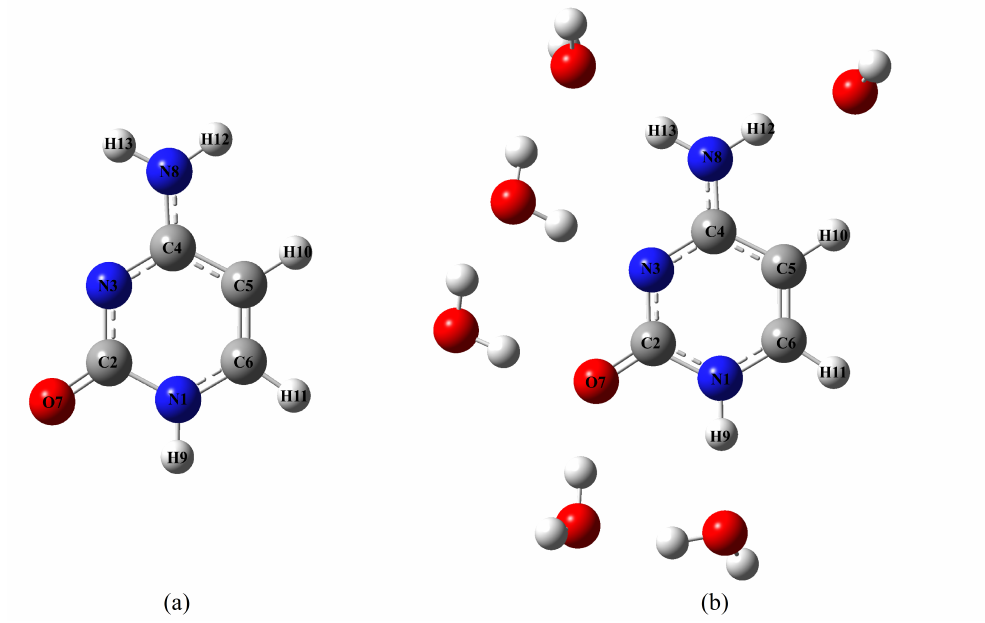
Figure 1. Molecular structures of the systems investigated in this work: ( a ) cytosine; ( b ) cluster cytosine ¨ 6H 2